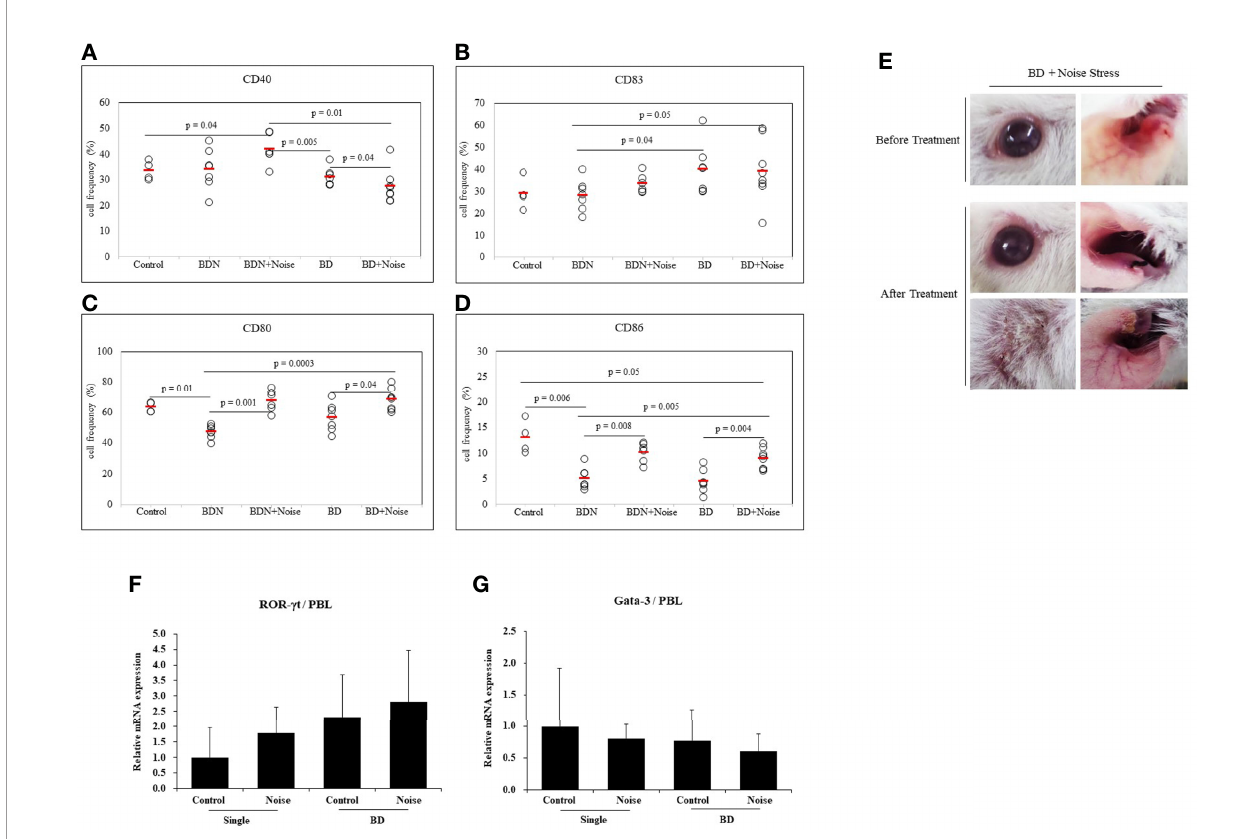
FIGURE 6 | Noise stress affects DC activation in BD mice. To investigate the correlation between noise stress and DC activation in BD, frequencies of DC activation markers CD40, CD83, CD80, and CD83 positive cells in peripheral blood leukocytes of noise-treated BD mice and BDN mouse were measured by fl ow cytometry (A – D) . BD mice under noise stress showed deteriorated or new symptoms (E) . Experiments were conducted independently at least three times. mRNA expression levels of cell transcription factors ROR- g t and Gata-3 in mice with only ocular symptoms and BD mice with ocular symptoms were analyzed by real time PCR. Both groups of mice were compared with mice in noise stress treated groups (F, G) . Statistical analysis was performed with Student ’ s t -test. The experiment was conducted in